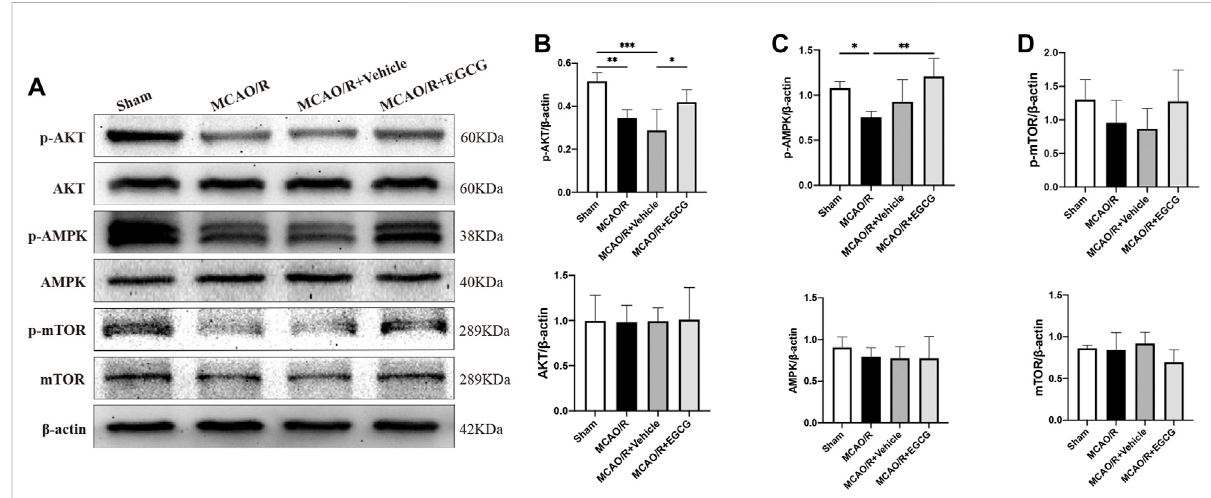
FIGURE 3 EGCG modulated the AKT/AMPK/mTOR phosphorylation pathway in middle cerebral artery occlusion/reperfusion (MCAO/R) mice. (A) The expression of p-AKT and AKT (B) , p-AMPK and AMPK (C) , p-mTOR and mTOR (D) was assessed by Western blotting assay. Each experimental datum was presented as mean ± standard deviation ( n = 3 animals per group). * p < 0.05, ** p < 0.01, *** p < 0.001 versus the speci fi ed